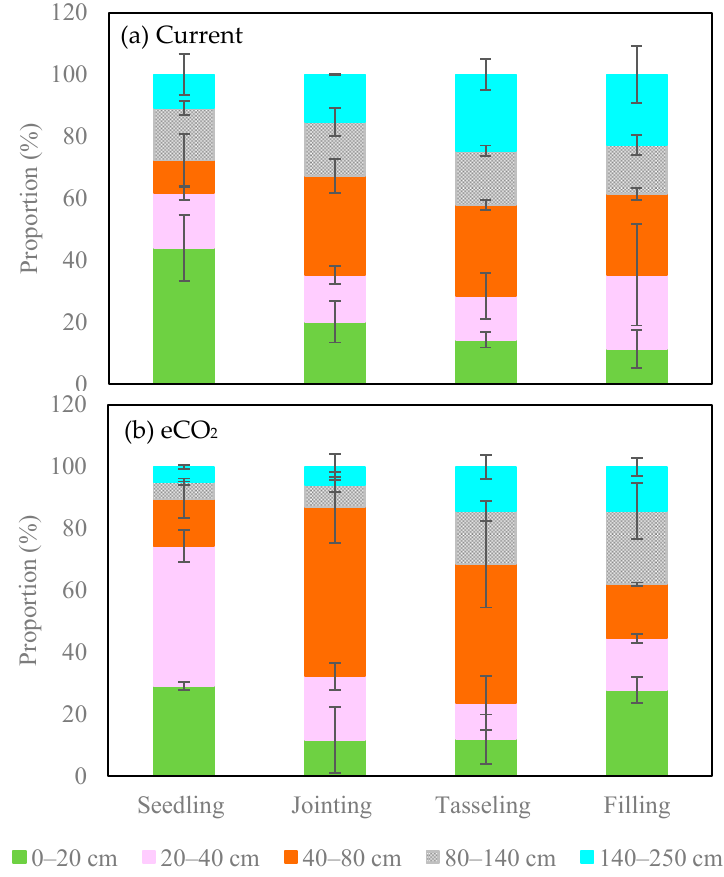
Figure 6 . Proportions of soil water contribution in each layer at different growth stages under ( a ) Figure 6. Proportions of soil water contribution in each layer at di ff erent growth stages under ( a ) current and ( b ) eCO 2 treatments, respectively. current and ( b ) eCO 2 treatments,